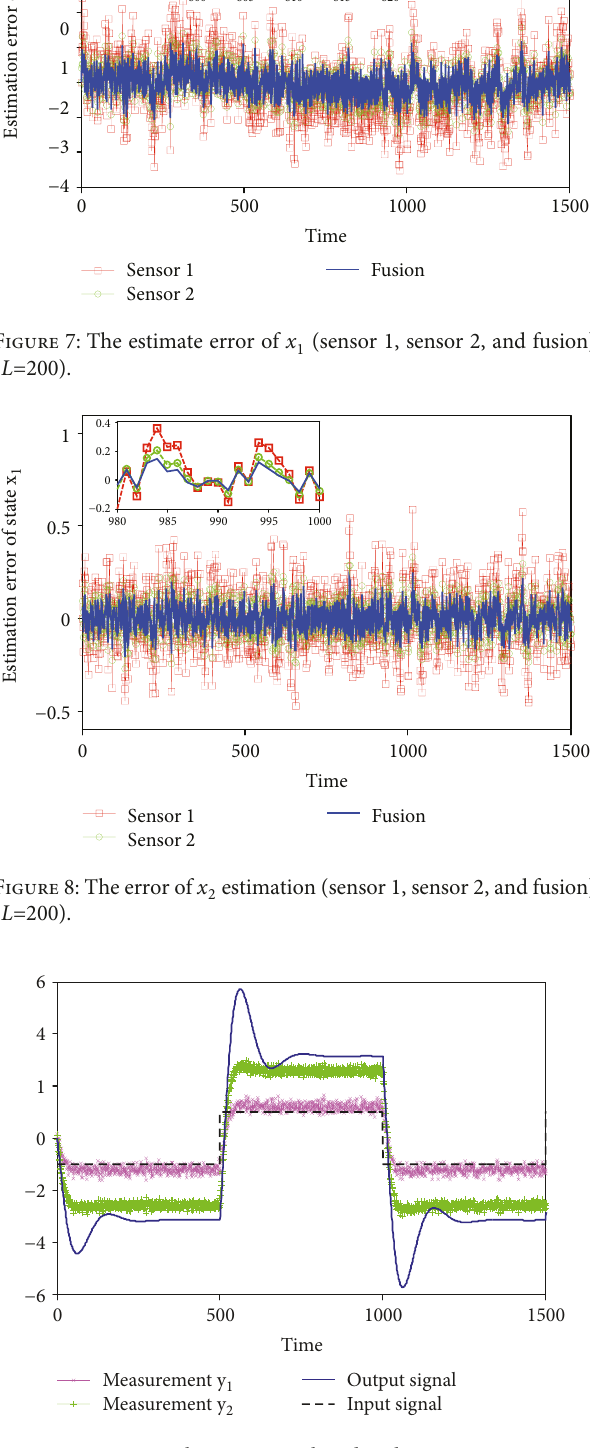
Figure 9: Input signal, output signal, and multisensor measurement ( L